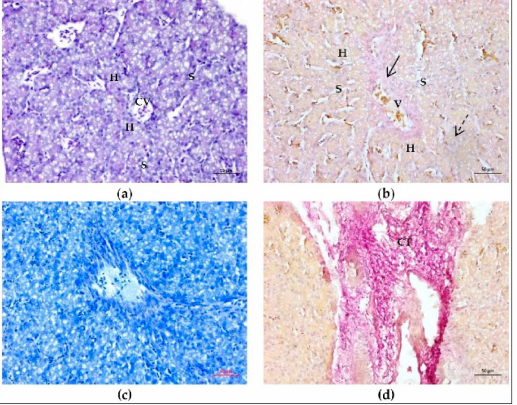
Figure A3. Histological structure of intact chick embryo liver extracted on ED18. ( a ) Hematoxylin and eosin staining reveals cords of hepatocytes (H) separated by narrow voids of sinusoids (S) arranged around the central vein (CV). The red blood cells in chick embryos are ellipsoid in shape and contain nuclei stained dark by hematoxylin. These cells are visible in the sinusoids and vein lumens. ( b ) In the samples stained by the Van Gieson’s method, the radial structure of hepatic lobule is more clearly discernible. Note pink staining of collagen (arrow) in the wall of a large vein (V) and more diffuse pink staining in the parenchymal part of the tissue (dashed arrow). ( c ) Orthochromatic staining of the liver tissue by toluidine blue indicates a low content of acid glycosaminoglycans. ( d ) Subcapsular area of the liver. Note connective tissue (CT) of the liver capsule and interlobular septae discernible by bright fuchsinofilia in samples stained by the Van Gieson’s method. Strong fuchsinofilic staining reflects high concentration of mature fibrillar collagen elements. Scale bars, 50 µ